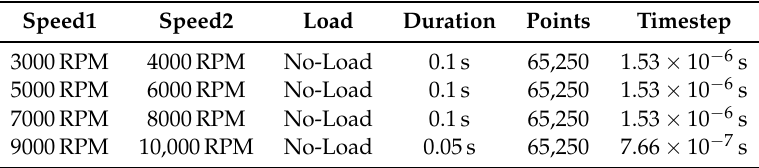
Table 6. Variable Speed Acquisitions summary.